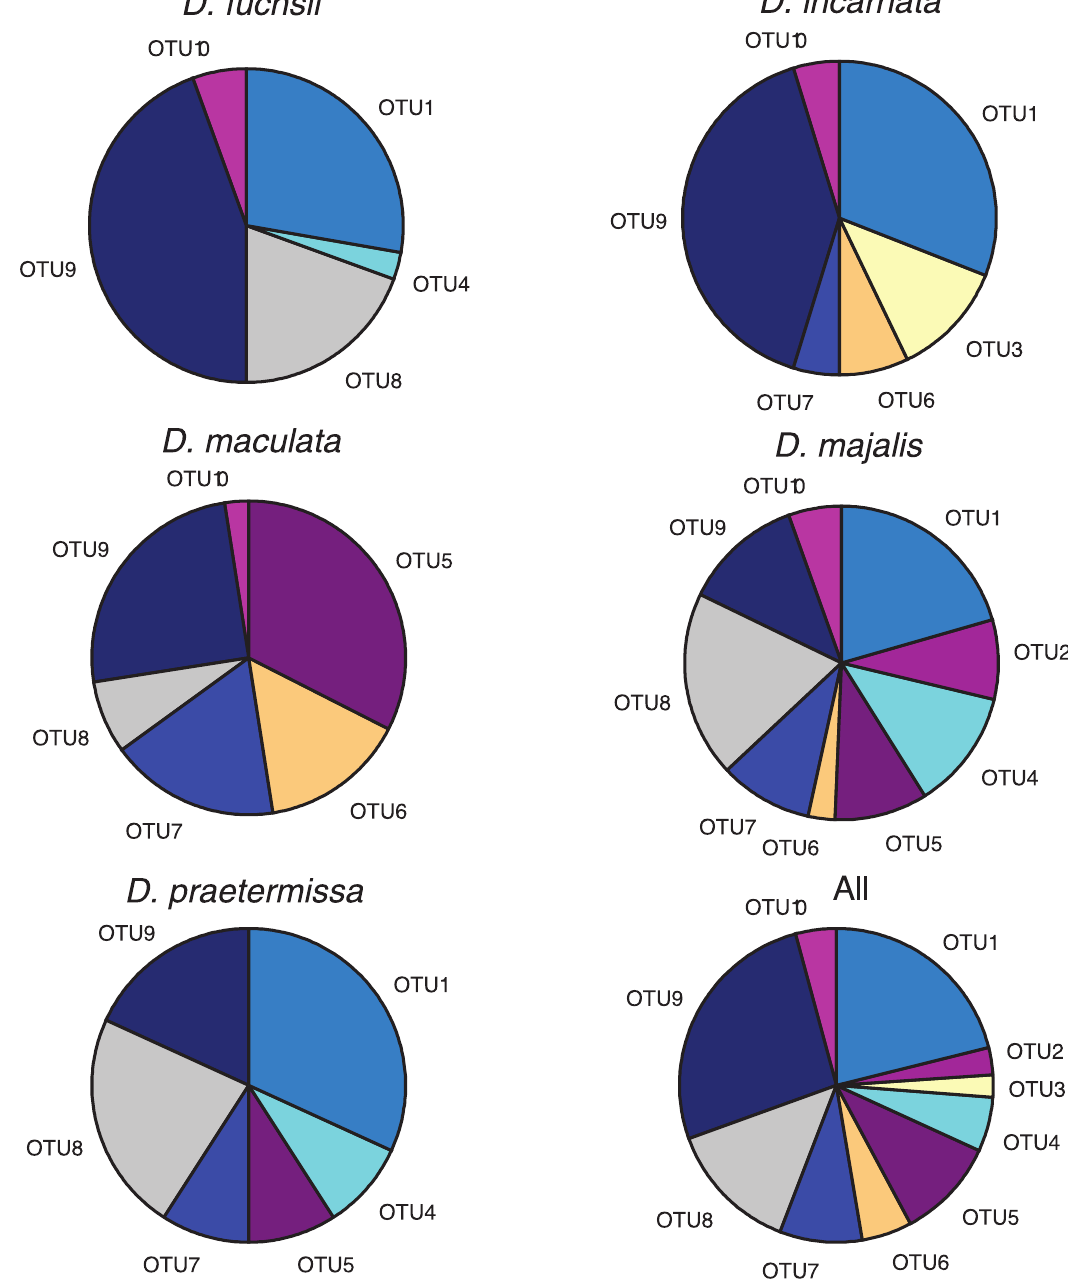
Figure 2. Frequency distribution of the ten observed operational taxonomic units (OTUs) among five Dactylorhiza species (a-e) and among all studied Dactylorhiza species together (f).